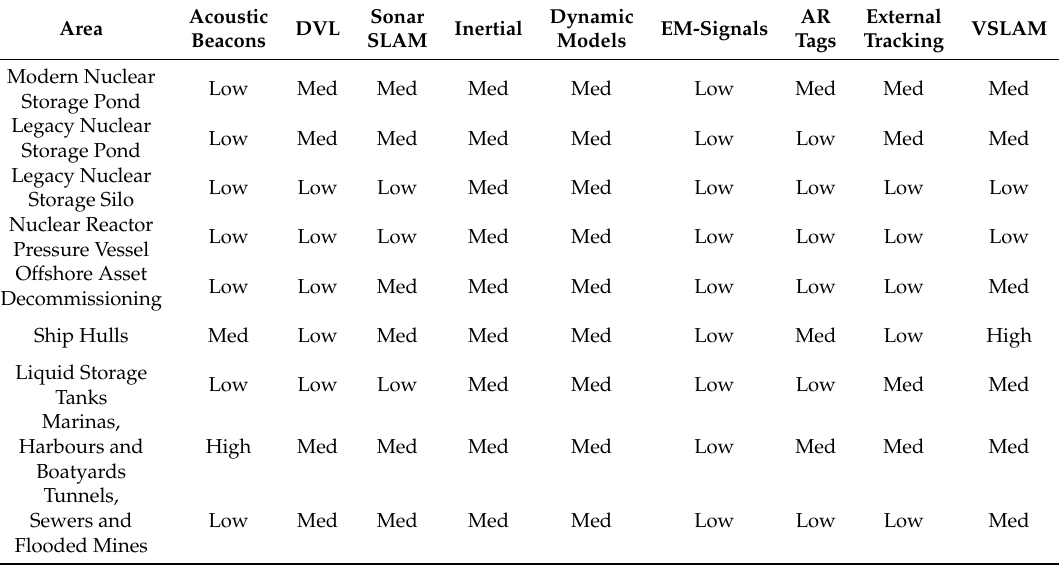
Table 6. Suitability of localisation Technologies for Different